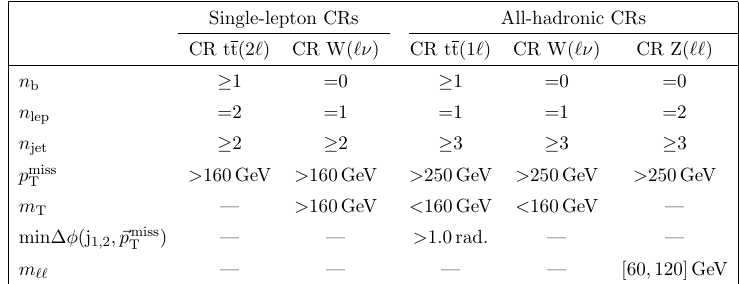
Table 2 . Control regions de(cid:12)ned for the main backgrounds of the SL SRs ((cid:12)rst two columns, tt(2 ‘ ) and W+jets) and the AH SRs (last 3 columns, tt(1 ‘ ), W+jets, and Z ! ‘‘ ). Some selections applied in the SRs are removed in the corresponding CRs to increase the available statistics and are therefore not listed. The p miss selection for the Z ! ‘‘ CR refers to the hadronic T